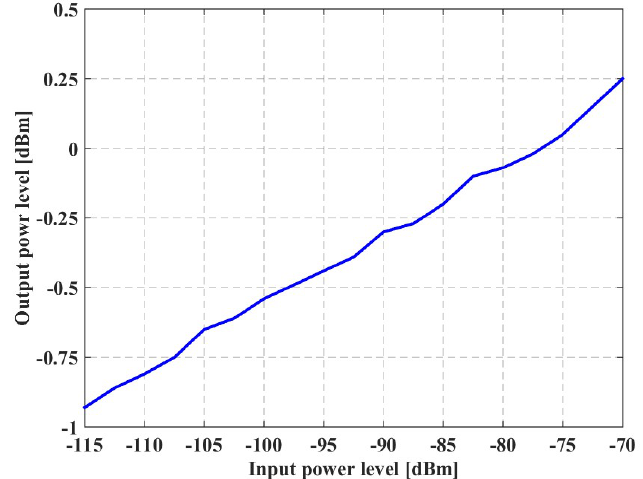
Figure 10. Measured input dynamic range of the receiver board for from −115 dBm to −70 dBm with a 2.5 dB step.